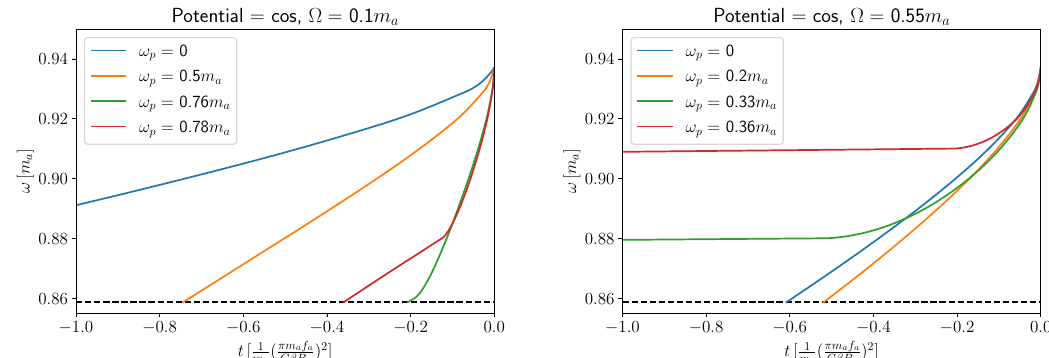
Figure 12 . Clump frequency ω as a function of time for the cos-potential for a few different values of the external magnetic field frequency Ω and the plasma frequency ω p . The dashed horizontal line shows the frequency corresponding to the initial central amplitude of the clump ˜ φ ( t 0 ) = 5 f a . As before ω ( t = 0) = ω crit .